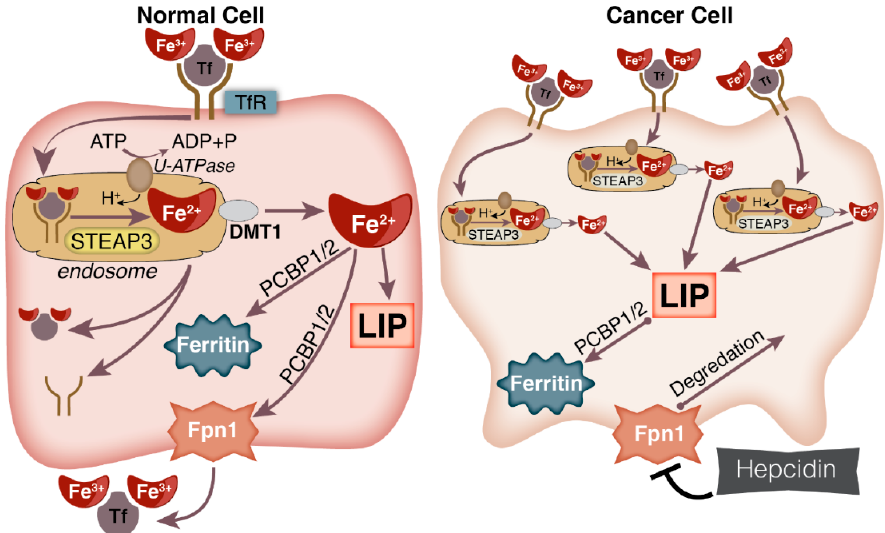
Figure 2. Alterations in iron uptake and efflux in cancer cells compared to normal cells. Cancer